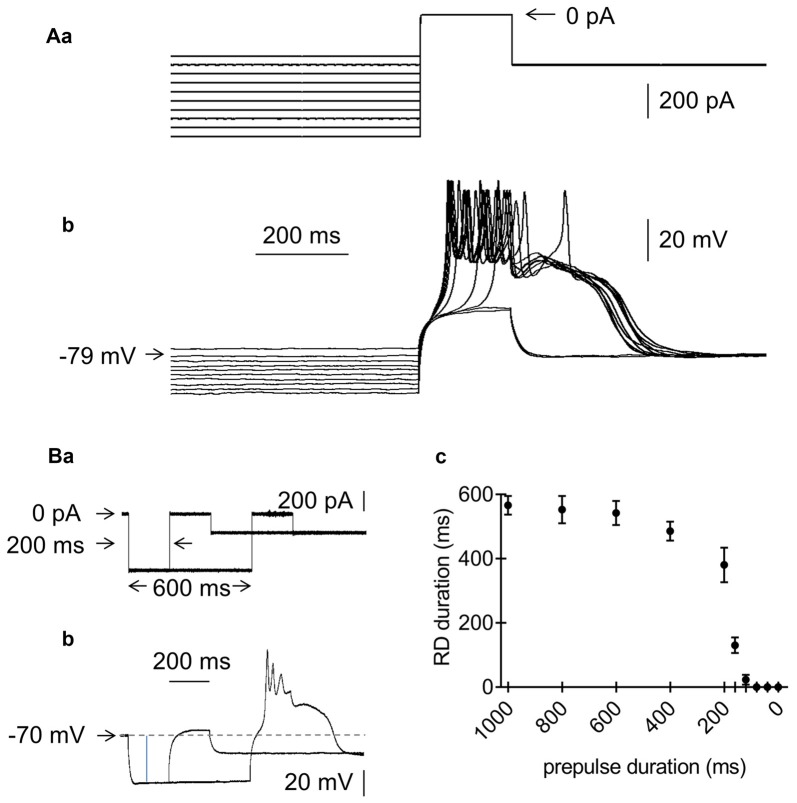
Effects of the amplitude and duration of the prepulse on RD in the absence of Ca++ in the extracellular solution. (Aa) Current protocol applied to study the effect of the prepulse amplitude on RD. Hyperpolarizing 1000-ms current prepulses from −700 pA to −250 pA were applied in 50-pA increments preceding the threshold current pulse to 0 pA, lasting 200 ms. Current pulses that evoked RD were followed by hyperpolarization to −300 pA, lasting 1300 ms. (b) RDs evoked by the current protocol shown in (a). RDs were evoked only at prepulse potentials more negative than −79 mV. (Ba) Current protocol applied to study the effect of the prepulse duration on the RD duration. The prepulse amplitude was −600 pA. The prepulse duration was changed from 1000 to 0 ms. Only 2 prepulses with durations of 200 and 600 ms are shown. The 200-ms threshold current pulse that evoked RD was 0 pA. The postpulse amplitude was −200 pA and lasted 1300 ms. (b) RD was evoked at a prepulse duration of 600 ms, but not at a prepulse duration of 200 ms (protocol of current pulses is shown in a). (c) Relationship between prepulse duration (horizontal axis) and RD duration (vertical axis).